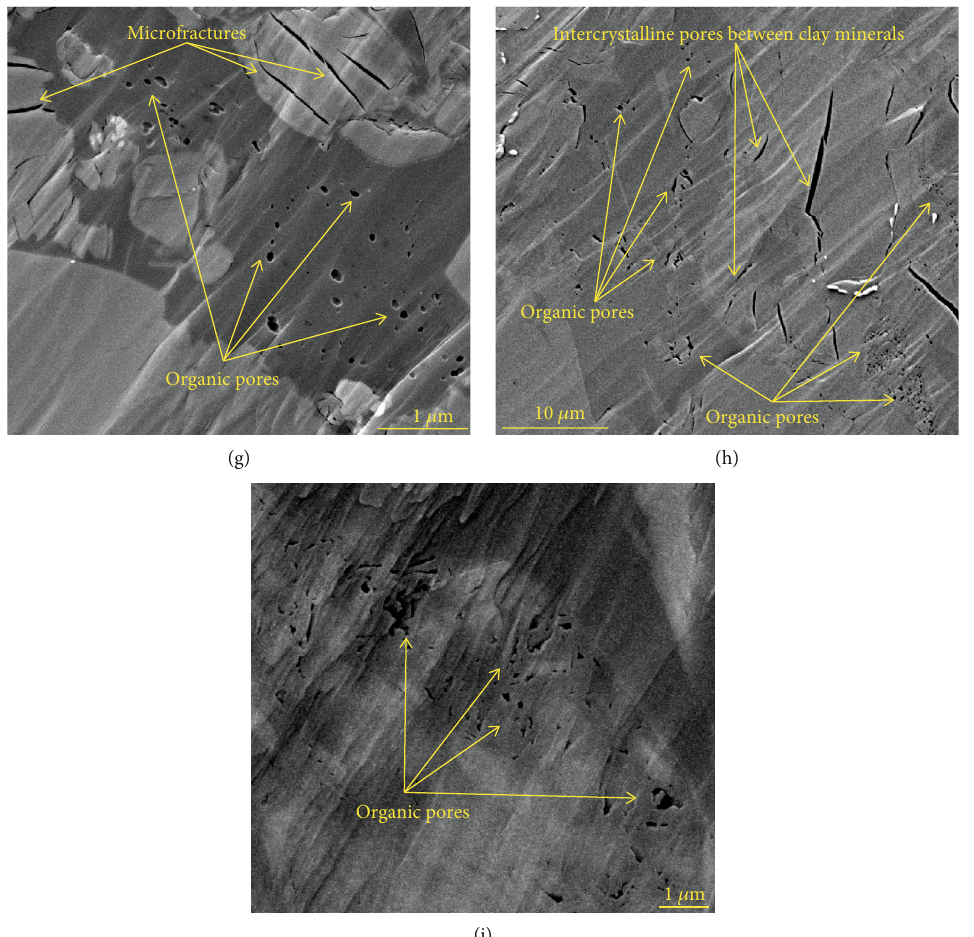
Figure 2: FE-SEM images of pores in Longtan shale samples ((a) sample from Well-XY1, 430.0m, black carbonaceous shale; (b) sample from Well- XY1, 443.5m, black carbonaceous shale; (c) sample from Well- XY1, 430.0m, black carbonaceous shale; (d) sample from Well-JS1, 751.0m, dark grey silty mudstone; (e) sample from Well-XY1, 439.0m, black carbonaceous shale; (f) sample from Well-JS1, 781.4m, black carbonaceous shale; (g) sample from Well-JS1, 781.4 m, black carbonaceous shale; (h) sample from Well-JS1, 779.3m, black carbonaceous shale; (i) sample from Well-JS1,781.4 m, black carbonaceous